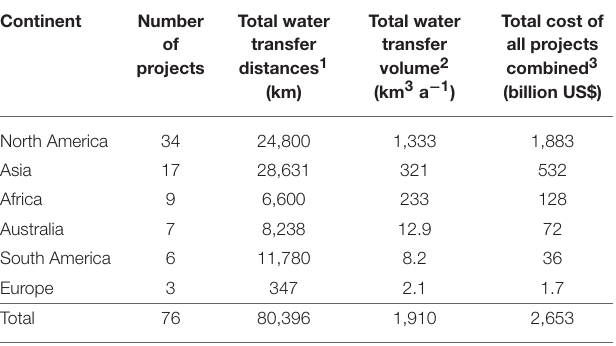
TABLE 1 | Summary information (per continent) on water transfer megaprojects, either proposed, planned or under construction (see text for further explanation). Continent Number